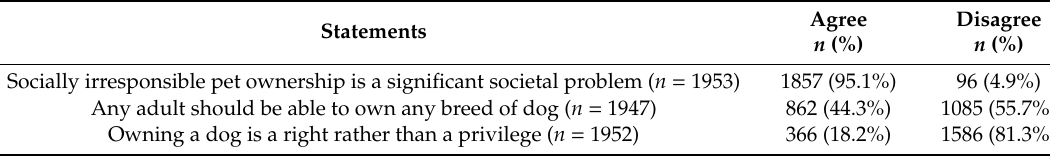
Table 4. Perceptions of pet ownership in the context of